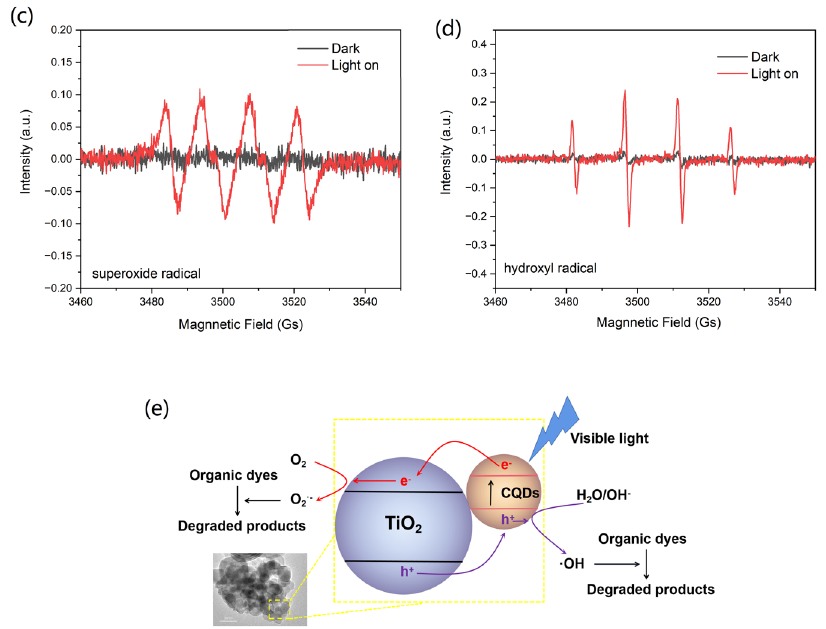
Figure 11. ( a , b ) DMPO spin-trapping ESR spectra of CQDs/TiO 2 composite in methanol ( a ) and water ( b ) under visible light irradiation; ( c , d ) DMPO spin-trapping ESR spectra of pure TiO 2 in methanol ( c ) and water ( d ) under visible light irradiation; ( e ) schematic illustration of the photocatalytic mechanism CQDs/TiO 2 composite.